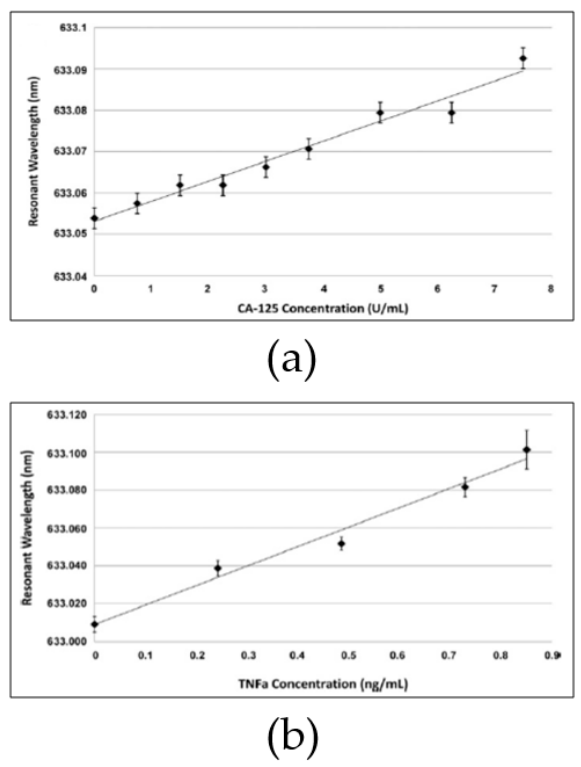
Figure 13. Calibration curves of microsphere performance. ( a ) CA-125 detection (38 µ m) shows the linear relation between the applied concentration and the resonance wavelength; ( b ) TNF- α (53 µ m) also shows the same relation. Reprinted with permission from [136].